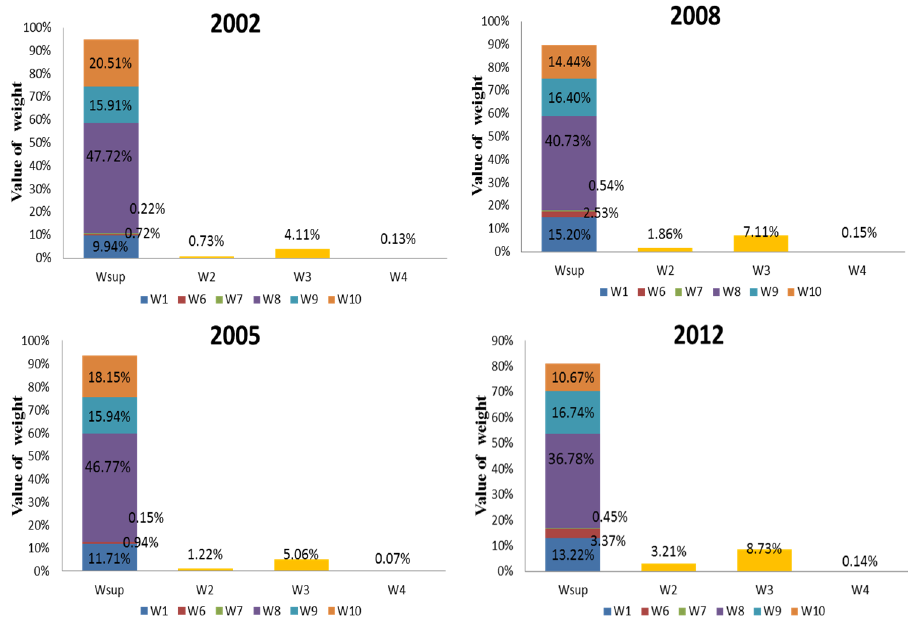
Figure 5. The weights of different nodes of China’s natural gas supply system from 2000 to 2012 based on a network model constructed on the RL. The first column, named Wsup, indicates the weights of supply sources, including internal sources. Within the Wsup column, the blue column at the bottom, denoted as W 1, indicates the production sector. External sources are shown in other colors in the first column. They are denoted as W 6, W 7, W 8, W 9, and W 10, representing the weights of the Middle East, Africa, Europe, Asia-Pacific, and North and South America, respectively. The second, third, and fourth columns represent the weights of the sectors of refining, consumption, and reserve, respectively, denoted as W 2, W 3, and W